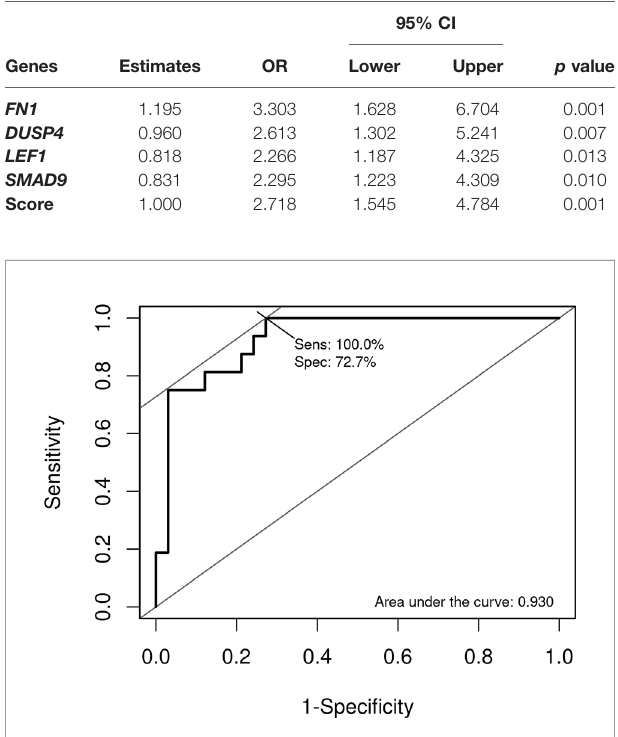
FIGURE 3 | Receiver operating characteristic (ROC) curve of the recurrence risk score (RRS). Sensitivity and speci fi city were determined by the Youden